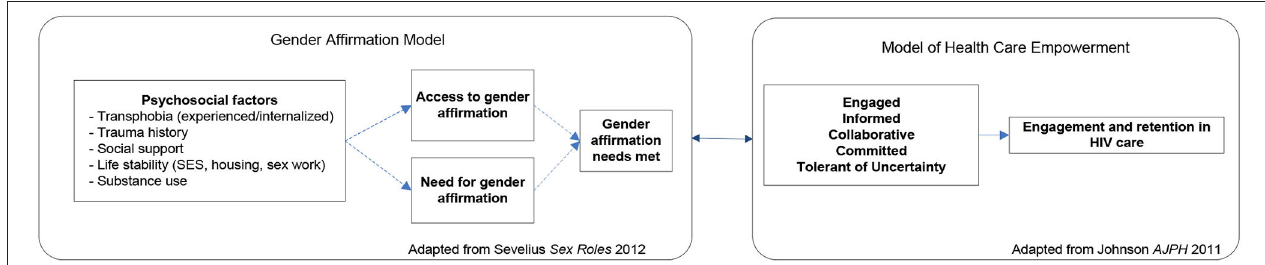
FIGURE 2 | Healthy Divas conceptual model integrating the Models of Gender Affirmation and Health Care Empowerment.